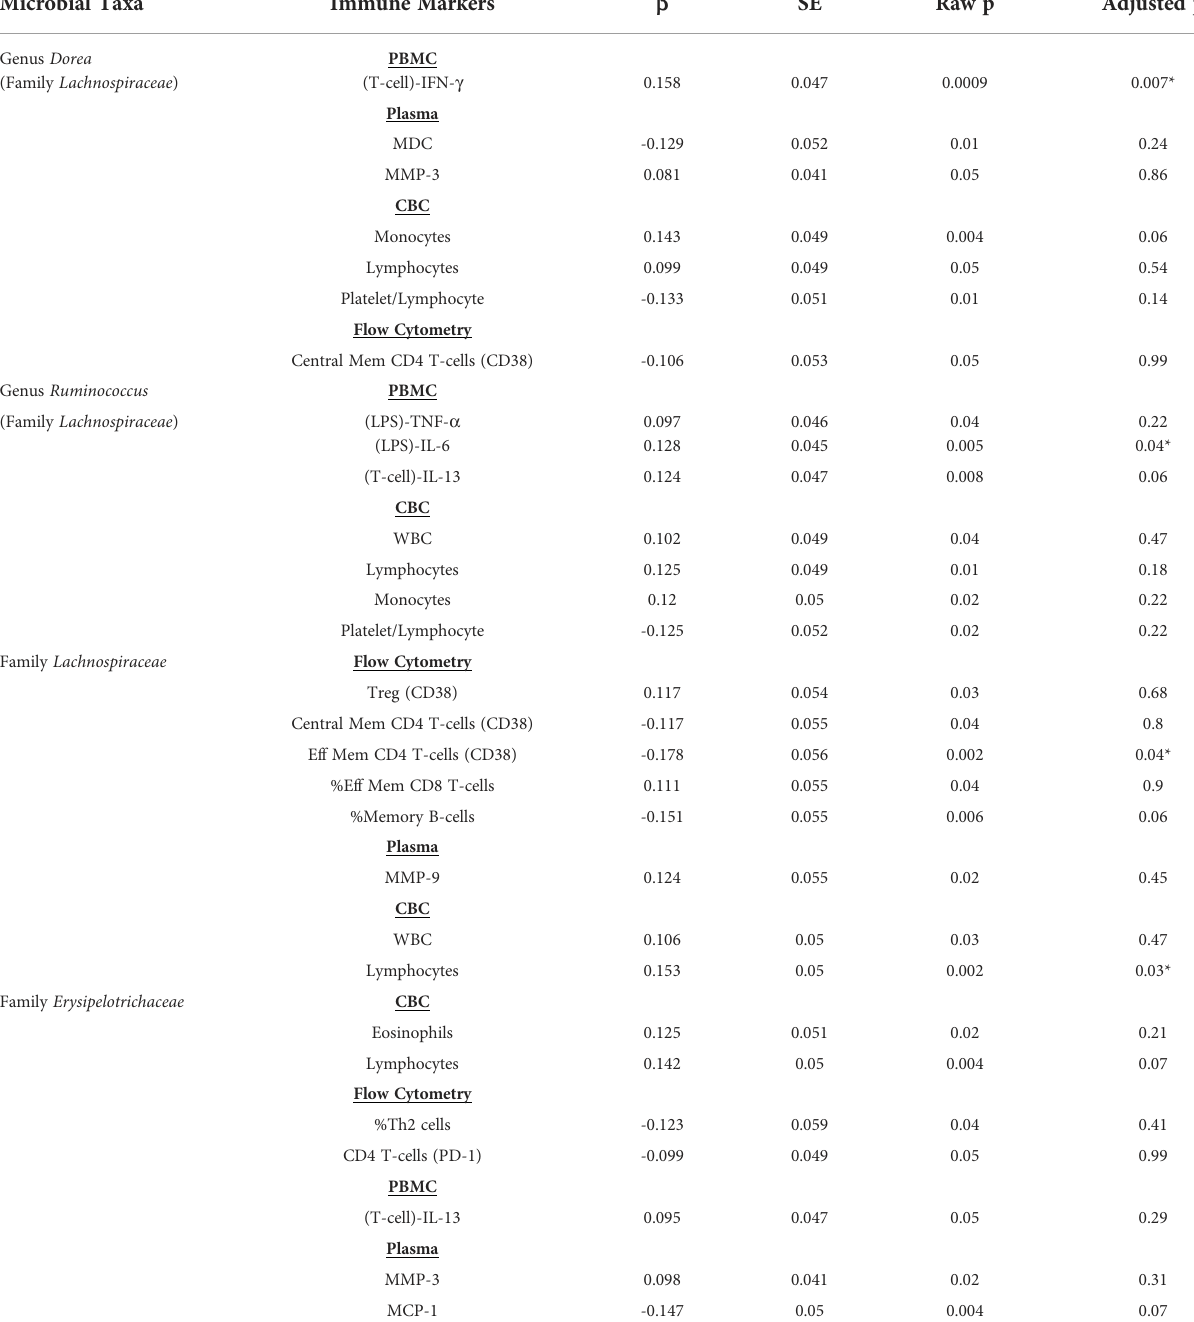
TABLE 2 Association of Trp metabolite-associated microbial taxa with markers of immune activity. Microbial